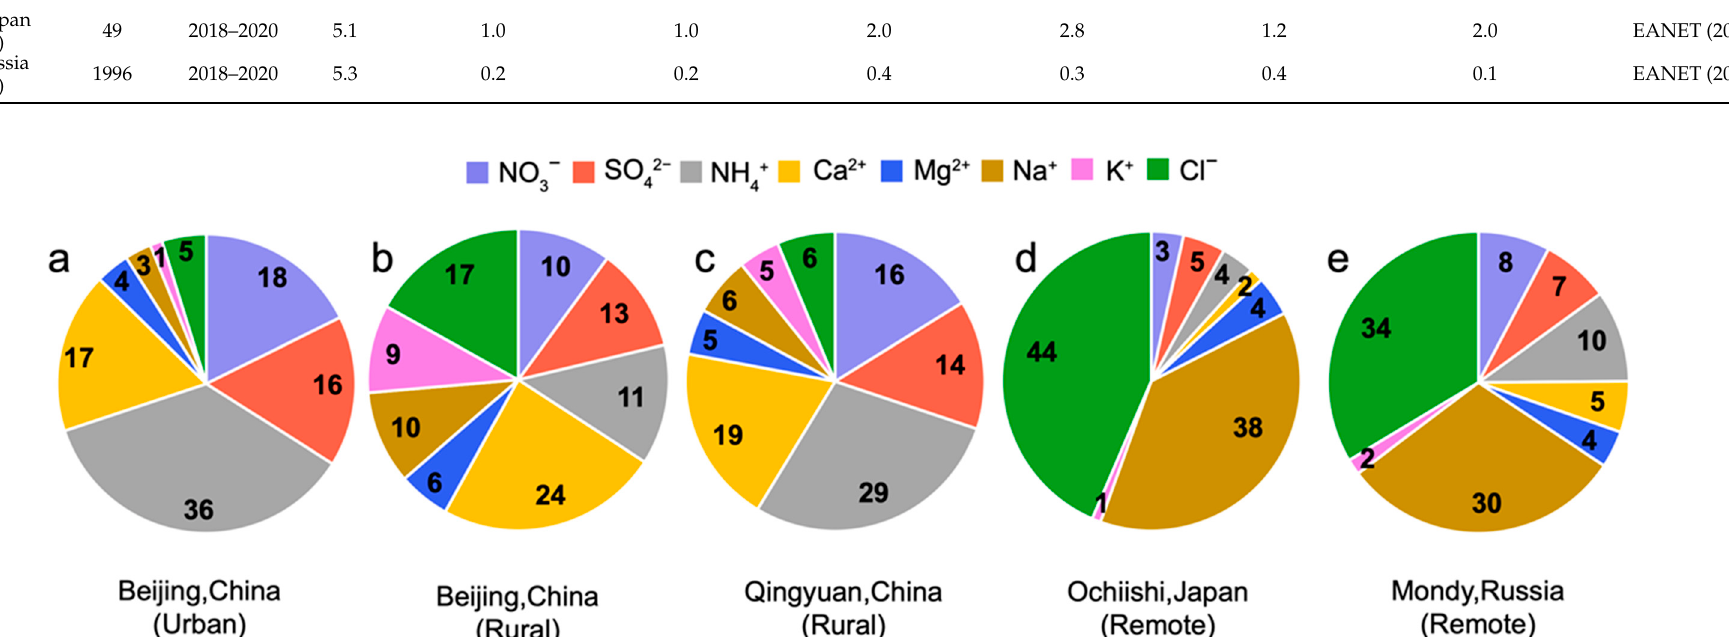
Figure 2. Percentages (%) of each ion to total ions in precipitation in Beijing urban site ( a ), Beijing rural site ( b ), the Qingyuan forest ( c ), Ochiishi ( d ), and Mondy ( e ) for comparison.